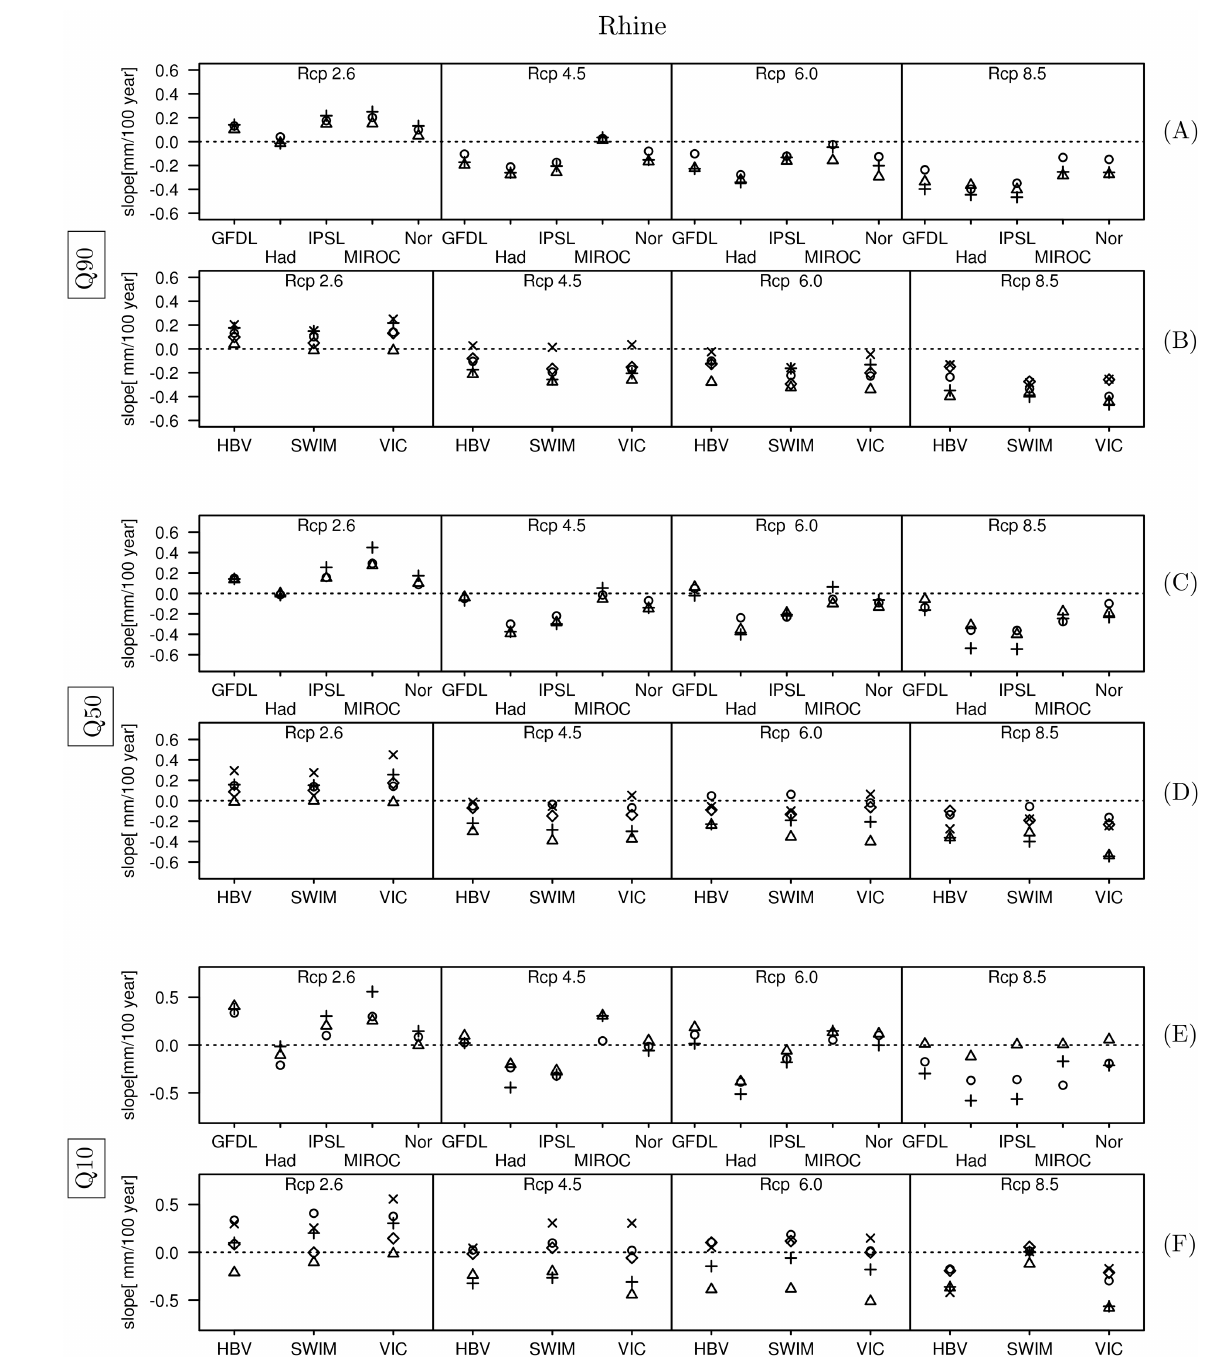
Figure A3. Slopes of trends in (a, b) low-flow percentile Q 90 , (c, d) medium discharge Q 50 and (e, f) high-flow percentile Q 10 grouped by climate models (a, c, e) and by hydrological models (b, d, f) for the Rhine.